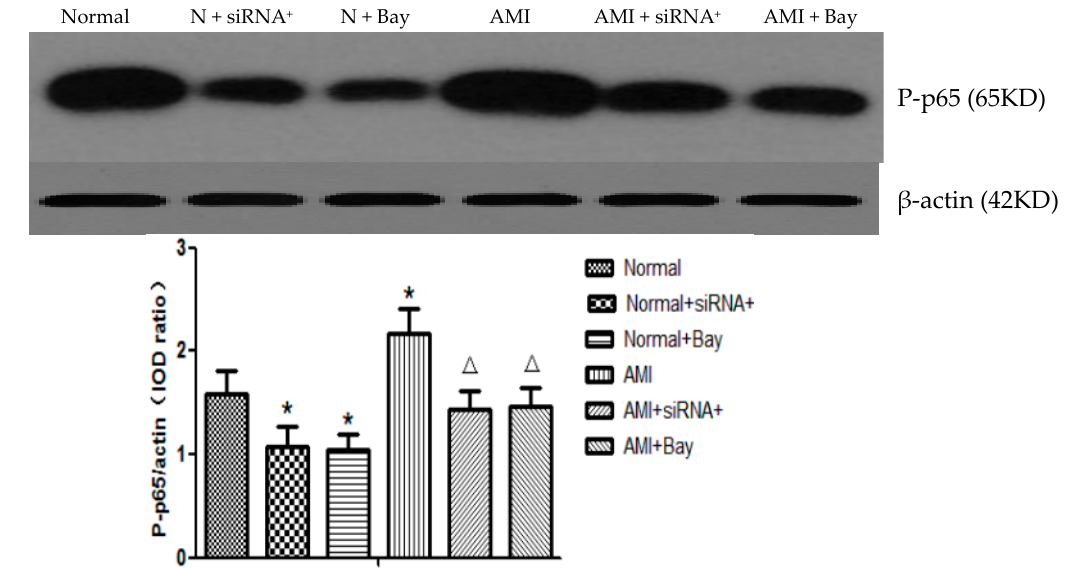
Figure 4. Expression of P-p65 in the T lymphocytes after CaSR siRNA transfection and adding of NF- κ B pathway blocker ( n = 20). The phosphorylation level of p65 protein in T lymphocytes increased greatly in AMI patients. Then, T lymphocytes were transfected by positive CaSR siRNA plasmid for 24 h or cultured by NF- κ B pathway blocker Bay-11-7082 (10 mM) for 15 min. In addition, the positive plasmid transfection in T lymphocytes and Bay-11-7082 reduced the expression level both in the normal and AMI groups. * p < 0.05 vs. Normal group; Δ p < 0.05 vs. AMI group.